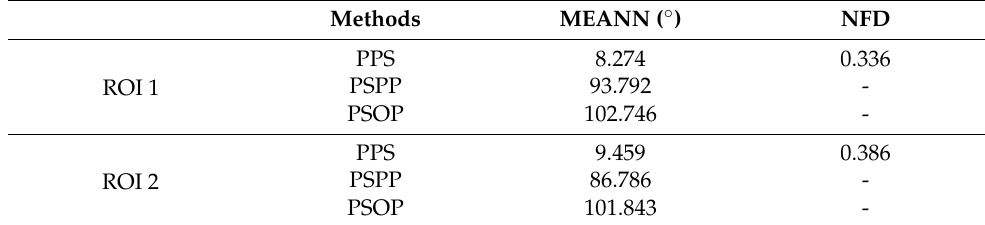
Table 5. Quantitative measures of three methods for Yutu-2 images.